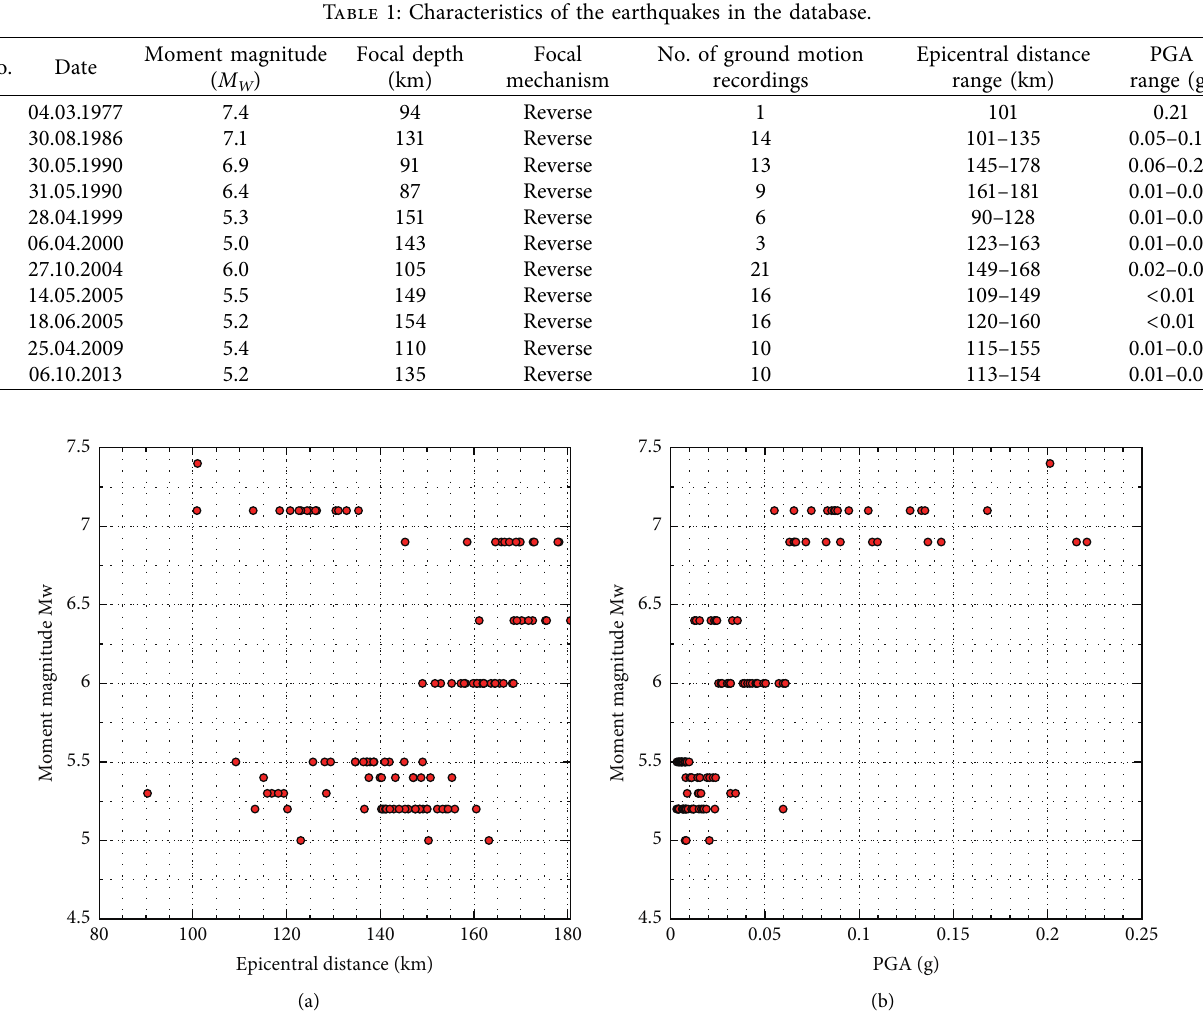
Figure 1: Distribution of the epicentral distance and peak ground acceleration with the earthquake magnitude for the